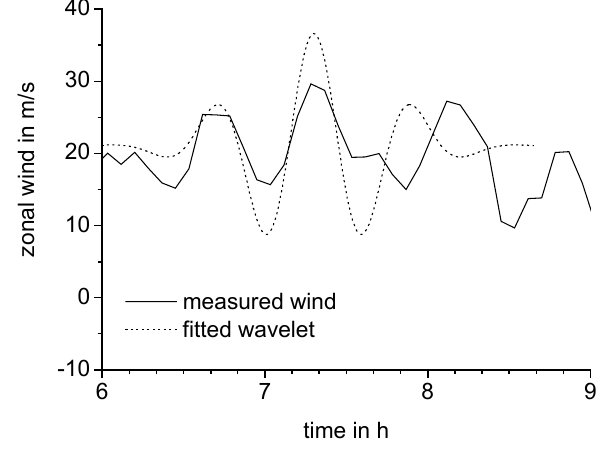
Figure 2: Example of 5-min time series and fitted wavelet function. Fig. 2. Example of 5-min time series and fitted wavelet